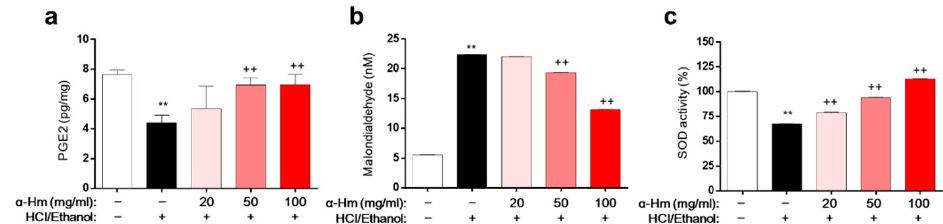
Figure 3. α -Humulene suppresses MDA formation and enhances PGE 2 levels and SOD activity. ( a ) Prostaglandin E 2 (PGE 2 ) levels in stomach tissues. ( b ) Levels of malondialdehyde (MDA). ( c ) Relative superoxide dismutase (SOD) activity. α -Hm: α -Humulene. ++ p < 0.01, ** p < 0.01.